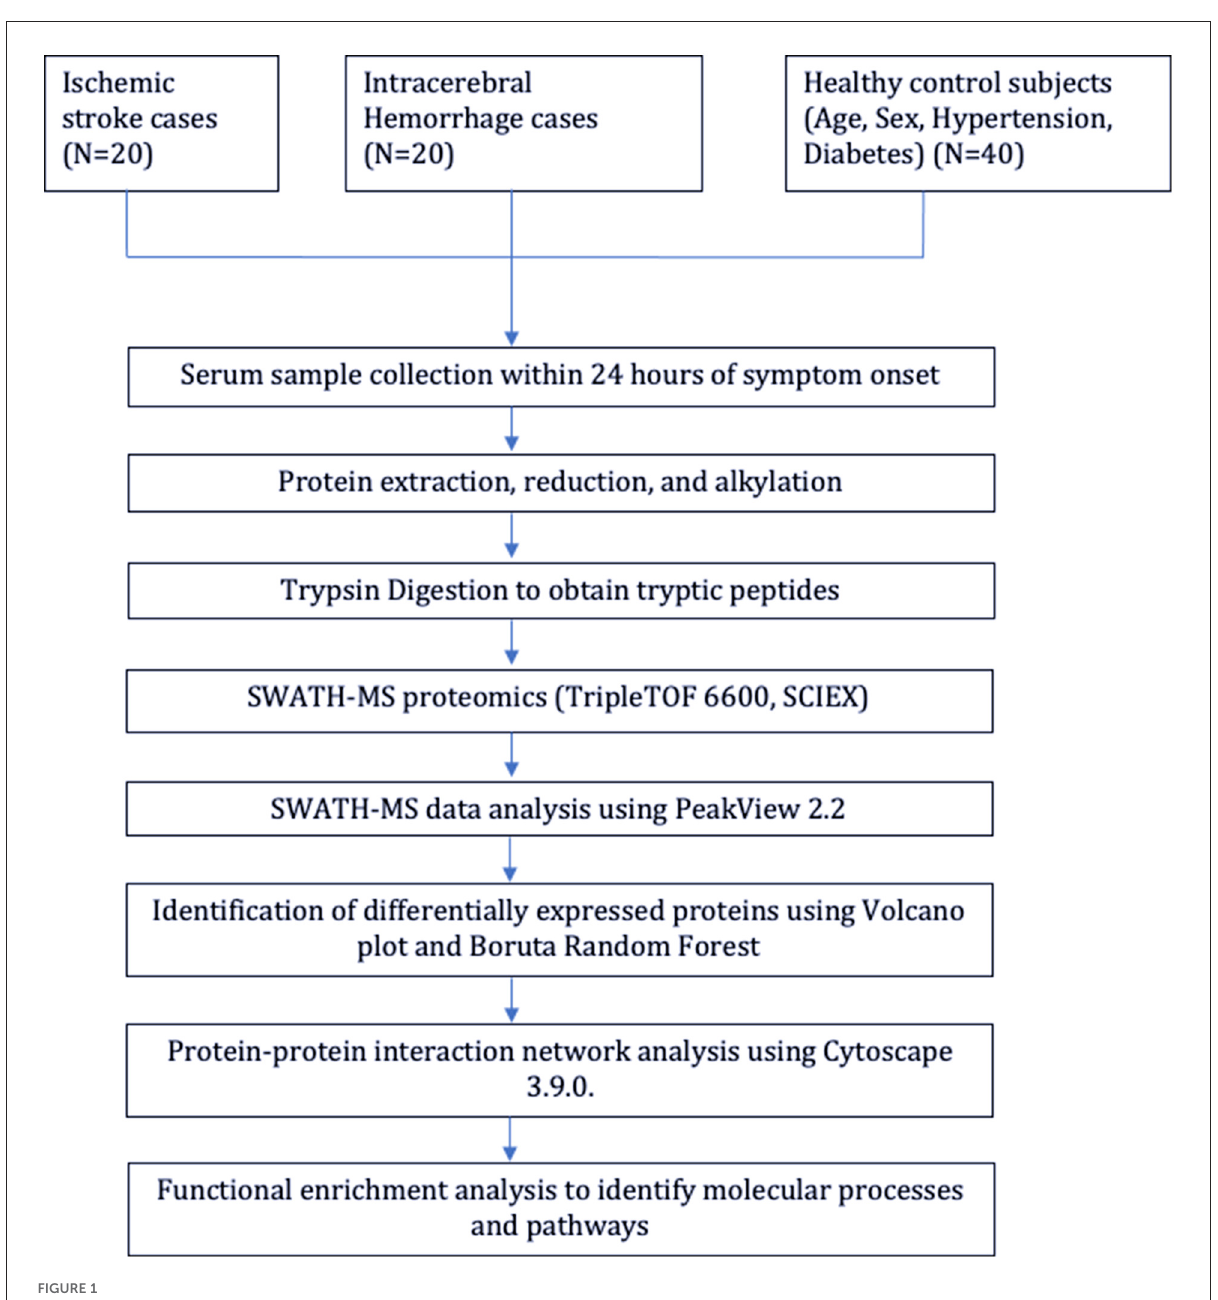
FIGURE1 Study flow